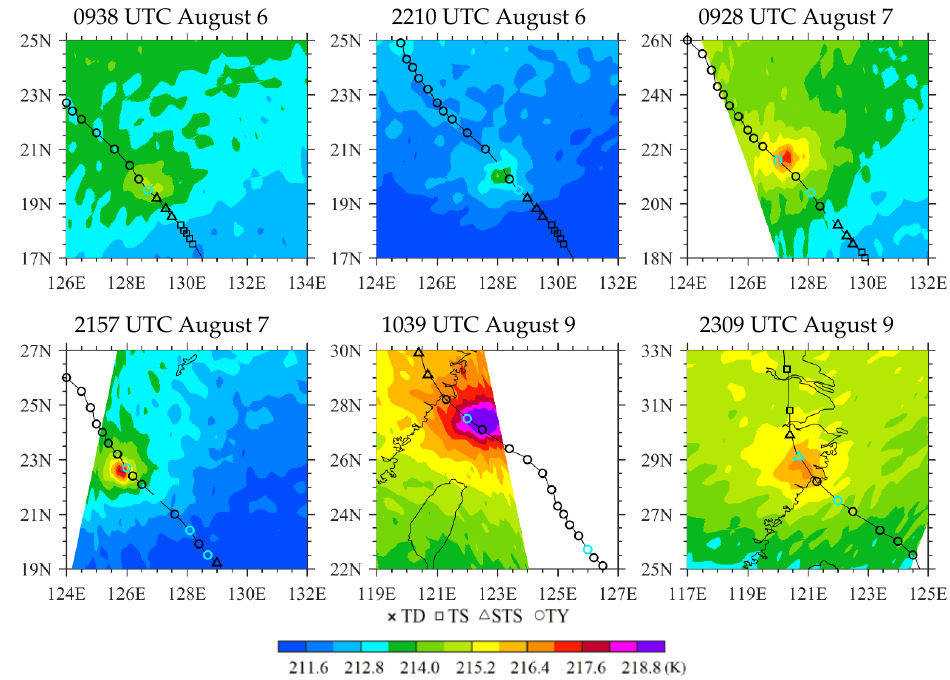
Figure 15. Same as Figure 14 except for channel 5, and the best track position at the time closest to the SSMIS observations is indicated in cyan symbol.